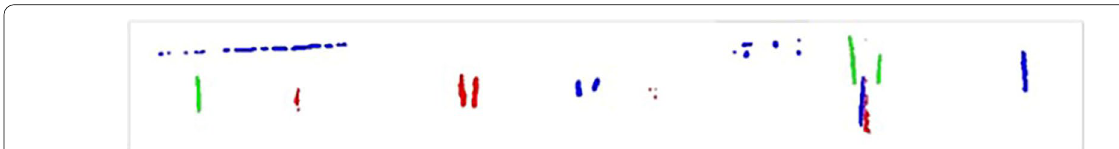
Figure 9 Ultrasound image in rail head